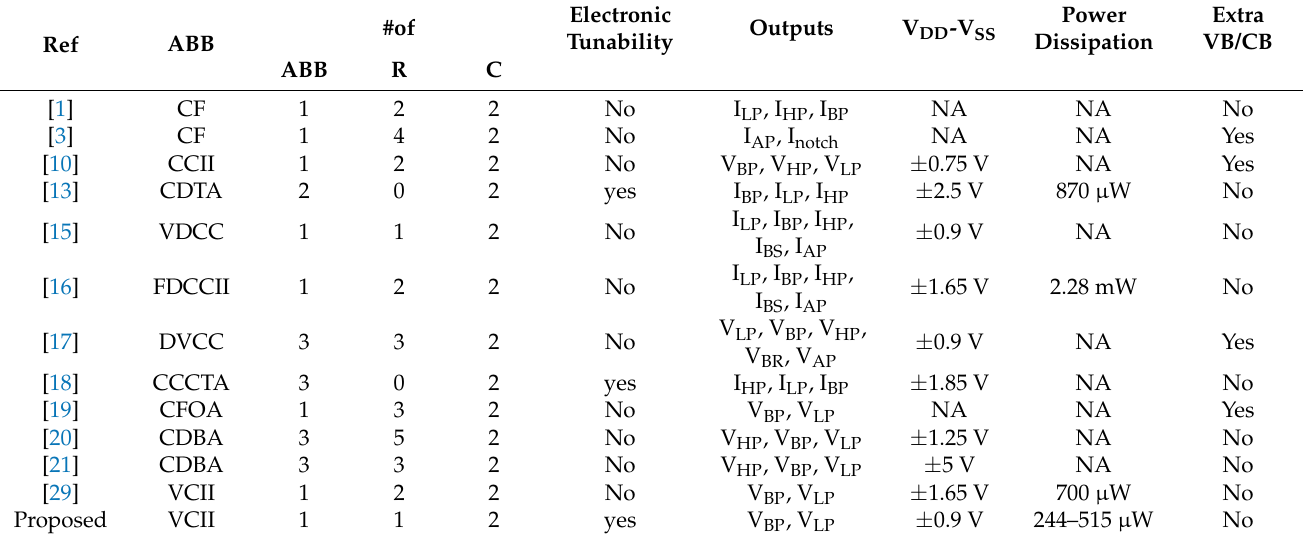
Table 3. Comparison between the proposed circuit and other reported